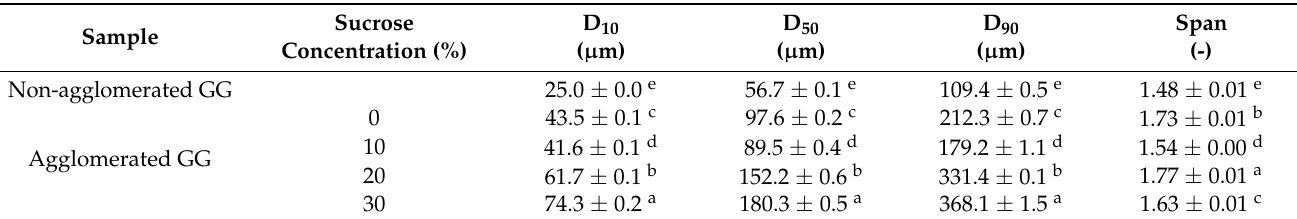
Figure 4. PSD of non-agglomerated and agglomerated guar gum (GG) with various concentrations of sucrose binder: ( ◯ ) non-agglomerated GG, ( □ ) GG–0%, ( △ ) GG–10%, ( ◇ ) GG–20%, and (×) GG– 30%.